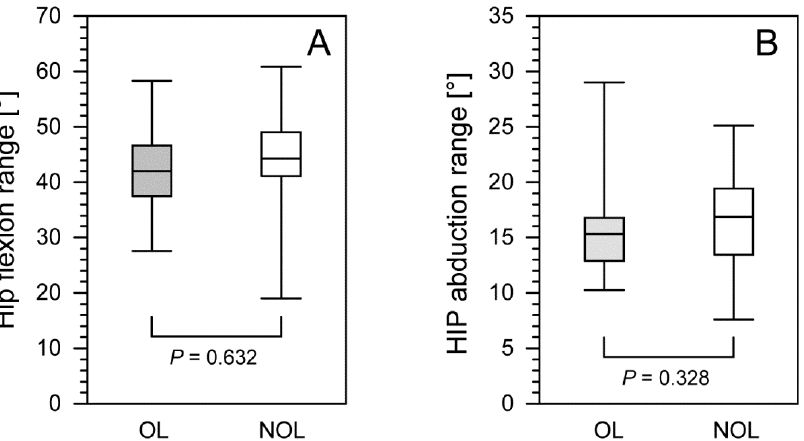
Figure 2. The comparison of hip flexion range ( panel A ) and hip abduction range ( panel B ) between the operated and non-operated limbs in patients after treatment with the Ilizarov method. The lower border of each box indicates the 25th percentile, the line within the box marks the median, and the upper border of each box indicates the 75th percentile. The whiskers above and below the boxes indicate the 90th and 10th percentile, respectively. Filled box, operated limb (OL); white box, non-operated limb (NOL).